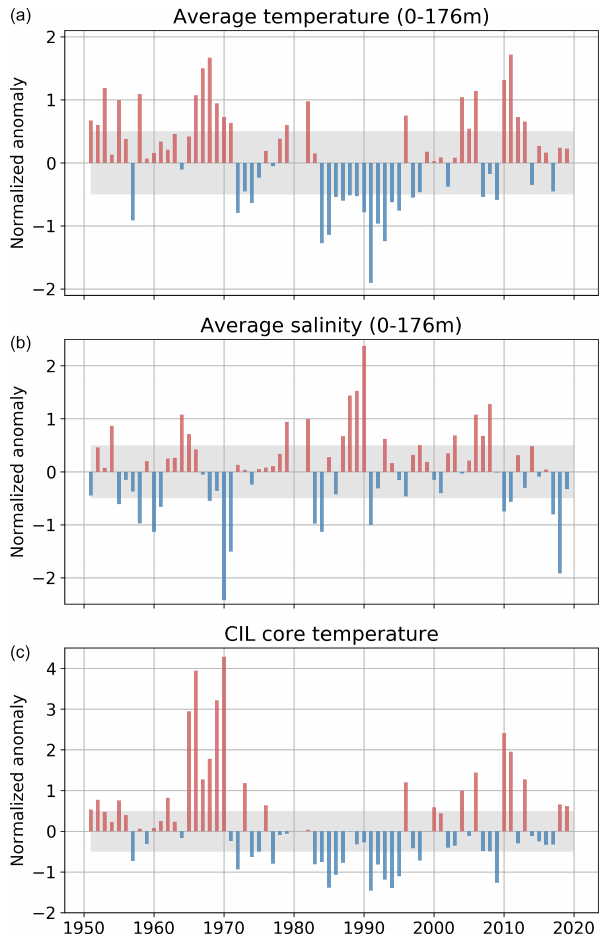
Figure 8. Normalized anomalies of the vertically averaged temper- ature (a) and salinity (b) and CIL core temperature (c) at Station 27. Shaded areas in all panels correspond to the 1991–2020 average ± 0 . 5SD. These three time series are components of the NL climate